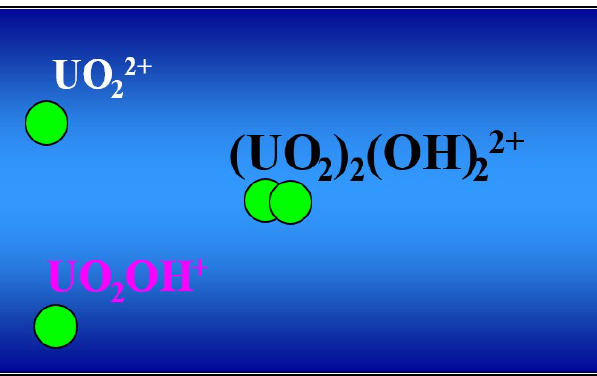
Fig. 1. An ionic scheme for uranium hydrolysis products in solution Fig. 1. Table 1. Table 1. Adsorption of uranium by immobilized